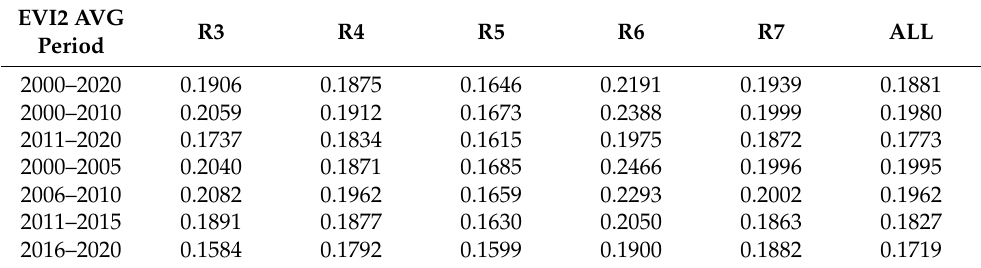
Table A4. The EVI2 difference between groups of years for the peak growing season, averaged between May 1 and October 30, is provided for each reach (R3 to R7) and the weighted average as All reaches. The groups include the entire 21-year period from 2000 to 2020; the ten-year periods